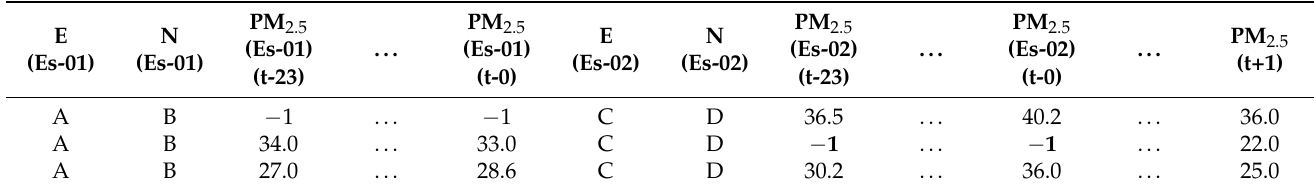
Table 4. Structure of the data expressed in time series. The columns to predict are indicated using padding with value 1. −